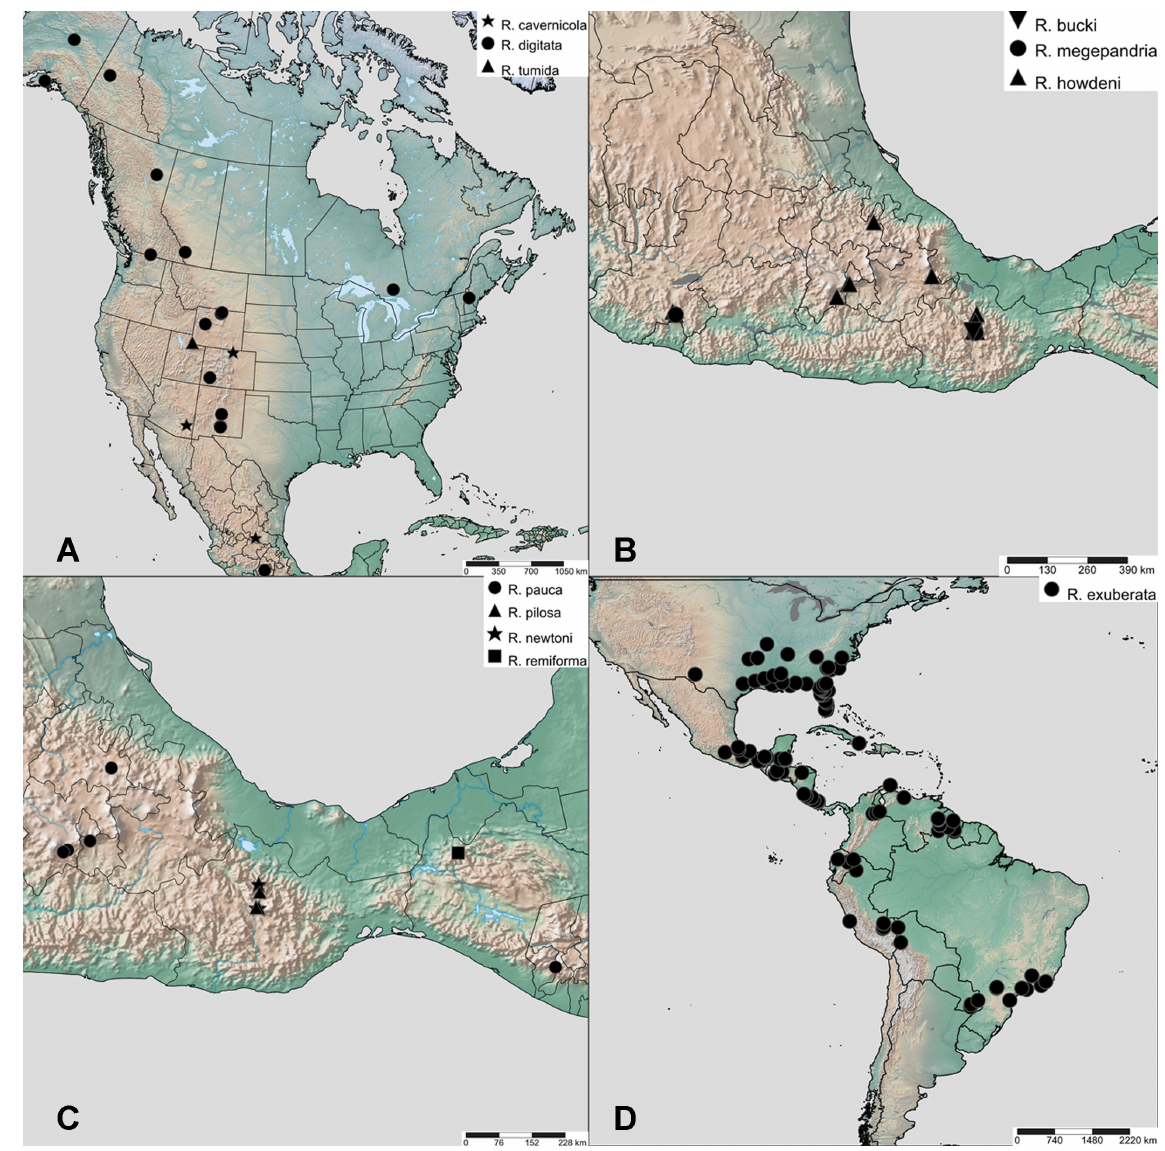
Fig. 21. Distribution of species of New World Rudolfina Roháček, 1987. A . R. cavernicola Marshall